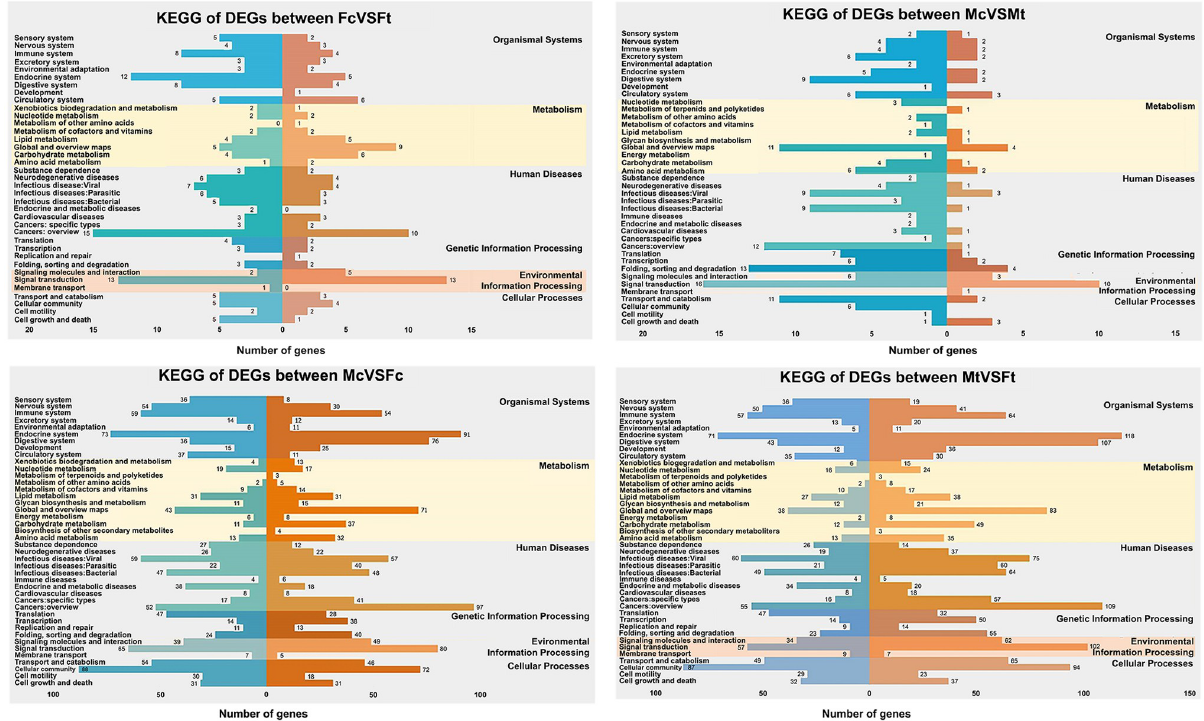
Fig 3. Kyoto Encyclopedia of Genes and Genomes (KEGG) enrichment analysis of differentially expressed genes (DEGs) between samples. DEGs that were upregulated are indicated in orange and color gradations of orange, whereas downregulated transcripts are shown in blue and color gradations of blue. FcVSFt; female control versus female DXM treated, MtVSFt; male DXM treated versus female DXM treated, McVSFc; male control versus female control, McVSMt; male control versus male DXM treated.